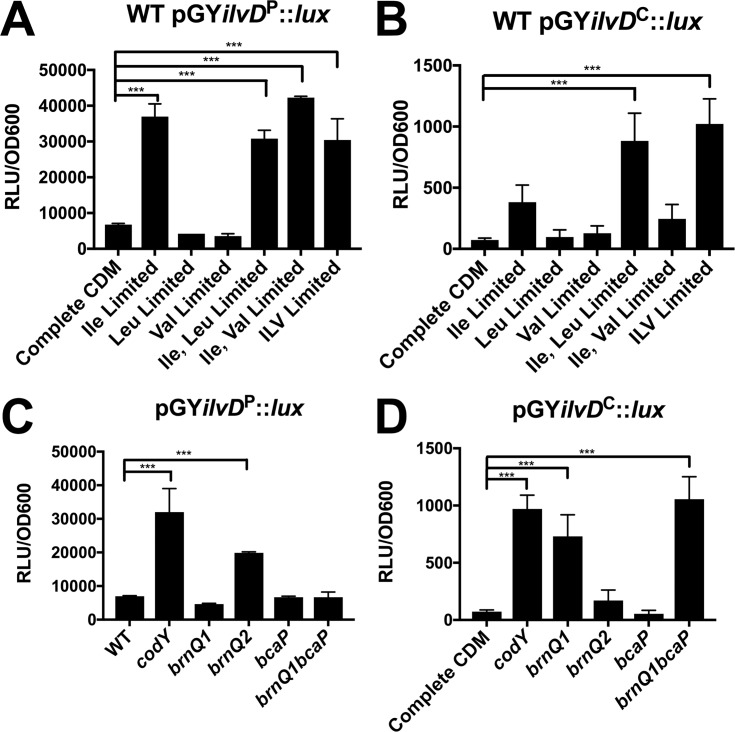
Ile is the predominant BCAA to regulate CodY activity on the ilvD promoter.WT S. aureus containing the lux reporter vector with either A) the partial ilvD promoter region (pGYilvDP::lux) or B) the complete ilvD promoter region (pGYilvDC::lux) was pre-grown in complete CDM to mid-exponential phase and then sub-cultured into either complete CDM or CDM with limiting concentrations of BCAAs, as indicated. Concentrations of Ile, Leu, and Val in complete CDM are 228 μM, 684 μM, 684 μM, respectively. Concentrations of Ile, Leu, and Val in limited media are 23 μM, 68 μM, and 68 μM, respectively. Luminescence values were read when cells reached mid-exponential phase and were normalized to the OD600nm. Data are the mean of three biological replicates +/- SD. S. aureus strains with mutations in either codY (codY::ϕNΣ) or BCAA transporters and containing either C) the partial ilvD promoter region (pGYilvDP::lux) or D) the complete ilvD promoter region (pGYilvDC::lux) were pre-grown in complete CDM to mid-exponential phase and then sub-cultured into complete CDM. Luminescence values were read when cells reached mid-exponential phase and were normalized to the OD600nm. Data are the mean of three biological replicates +/- SD. Data were analyzed by one-way ANOVA with Dunnet’s multiple comparisons test. *** P < 0.001.